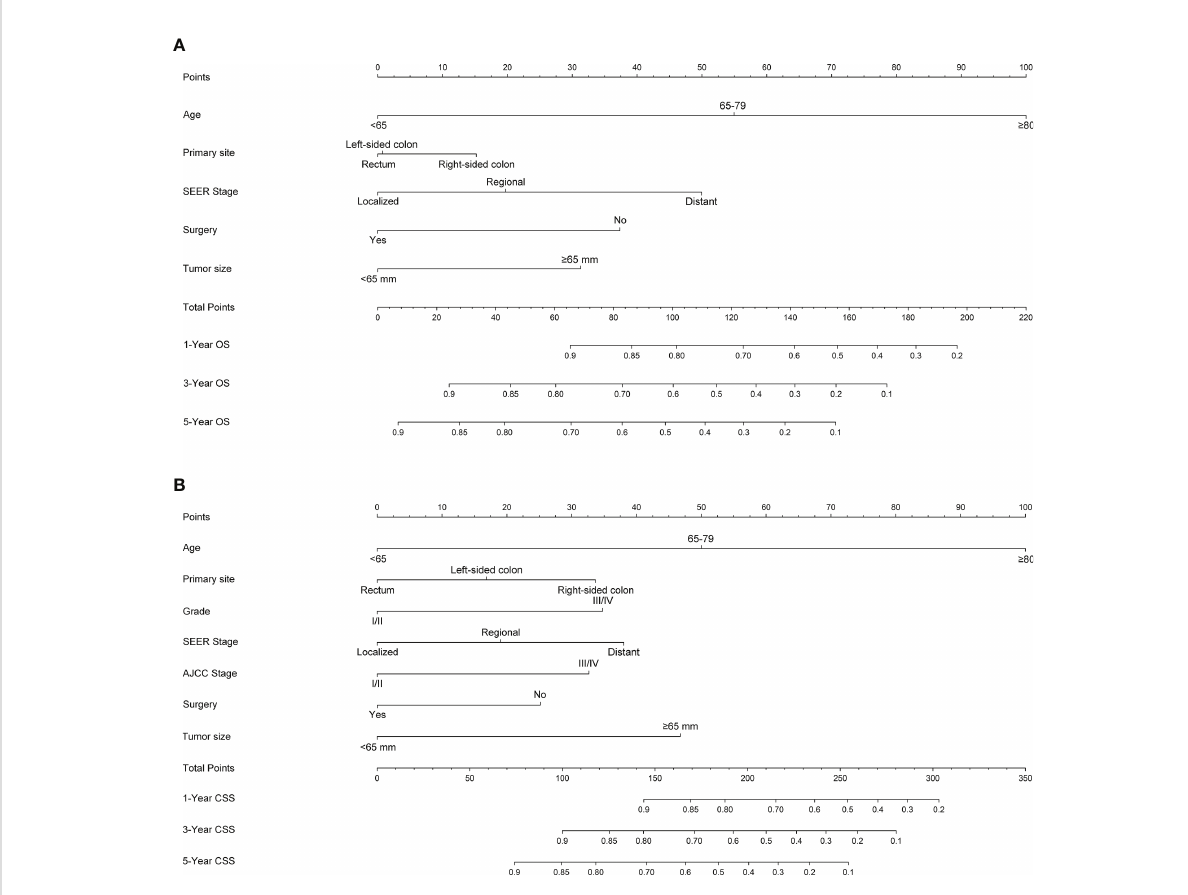
FIGURE 1 Nomogram predicting 1-, 3- and 5-year (A) OS, (B) and CSS of patients with Colorectal GISTs. Summarizing the scores of each variable together and the total points projected on the bottom scales indicate the probabilities of 1-, 3- and 5-year OS and CSS. OS, overall survival; CSS, cancer- speci fi c survival; Colorectal GISTs, Colorectal gastrointestinal stromal